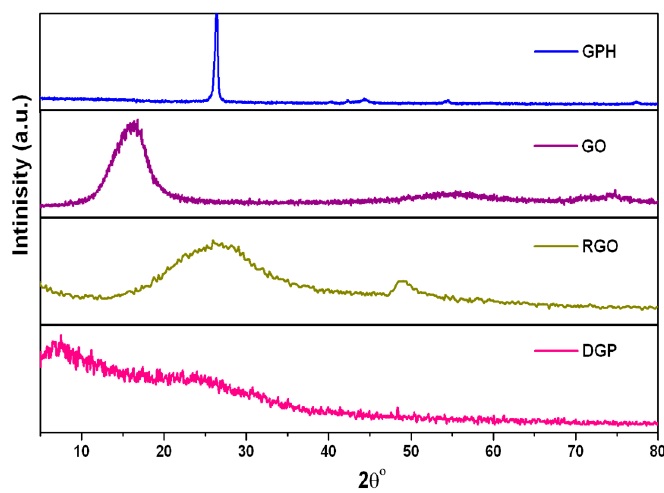
Figure 3. X-ray diffraction spectra of graphite (GPH), dispersed graphene platelets (DGP), graphene oxide (GO) and reduced graphene oxide (RGO).